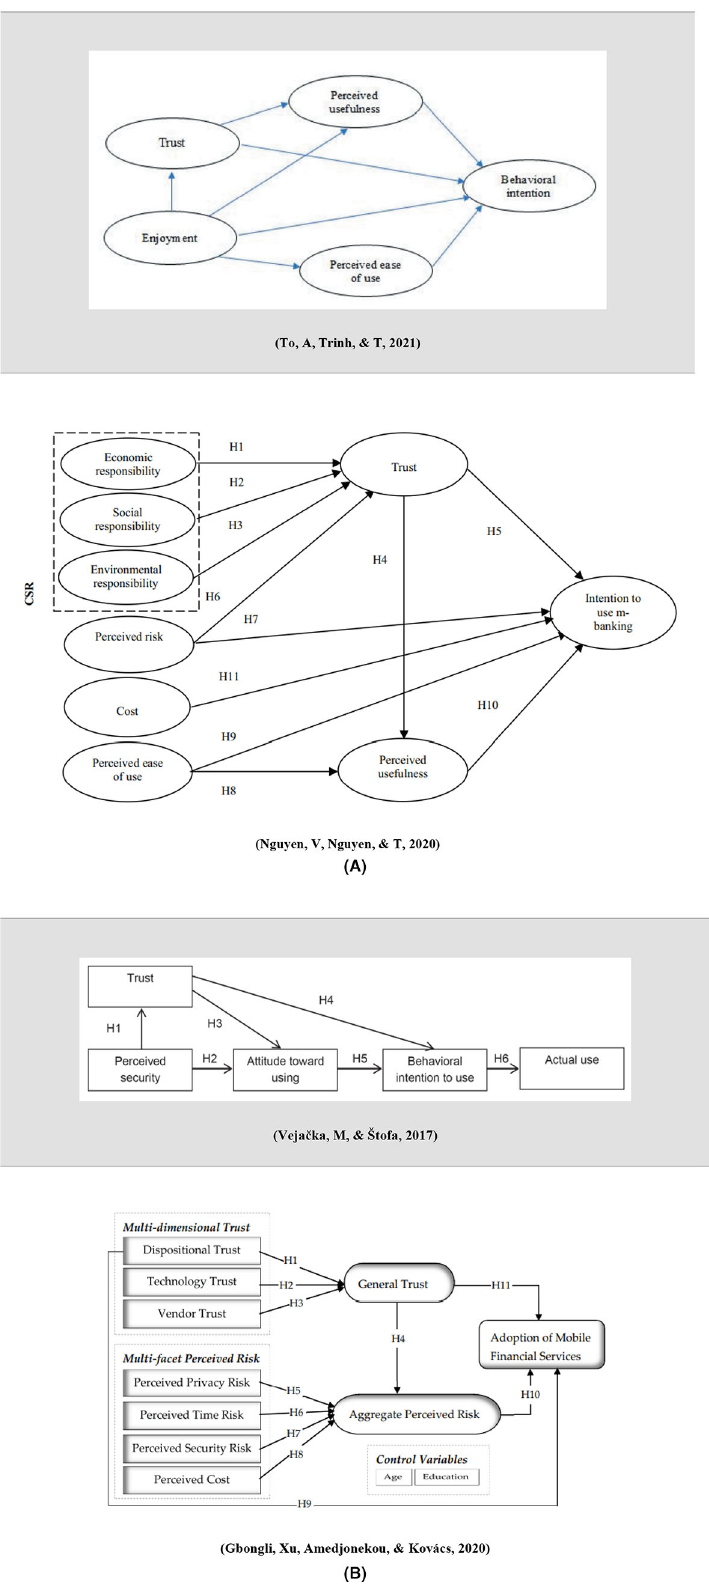
Figure 2. Research